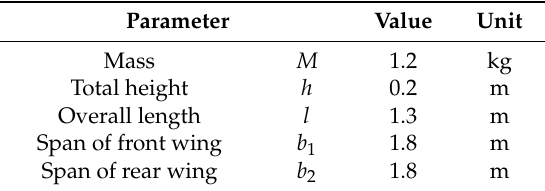
Table 5. Specification of the Quad Tilt-Wing Unmanned Aerial Vehicle (QTW-UAV).